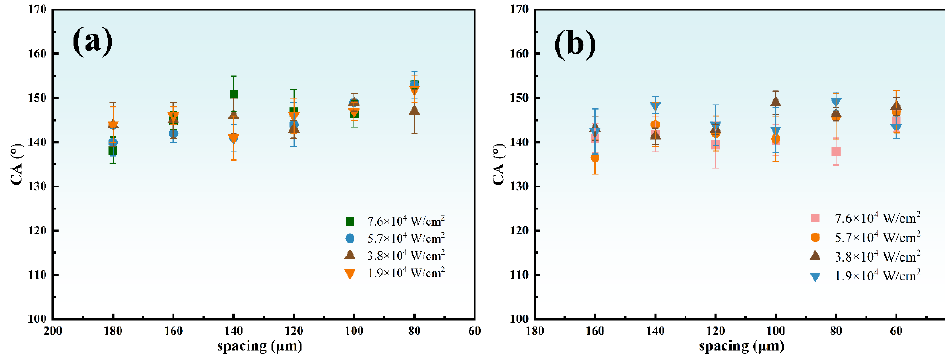
Figure 6. Static contact angles on different surfaces ( a ) groove structure ( b ) grid structure.